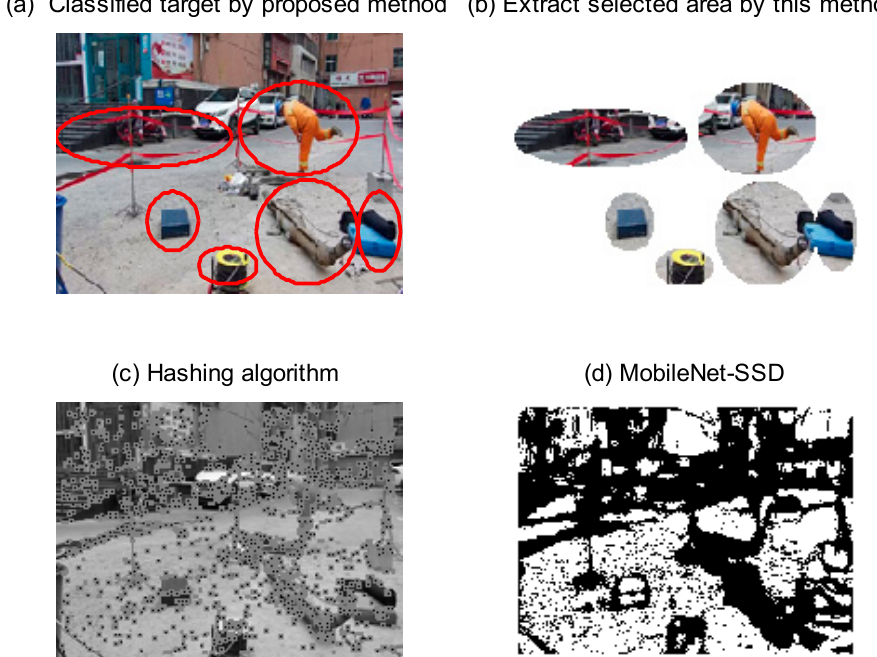
Figure 6. E ff ectiveness of the classi fi cation algorithm proposed for the classi fi cation of construction Figure 6. Effectiveness of the classification algorithm proposed for the classification of construction site targets. site